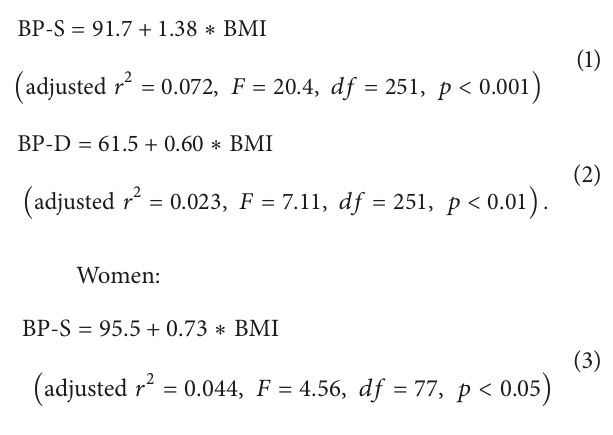
BP-D = 61.3 + 0.58 ∗ BMI ( adjusted 𝑟 2 = 0.062, 𝐹 = 6.09, 𝑑𝑓 = 77, 𝑝 < 0.05) .